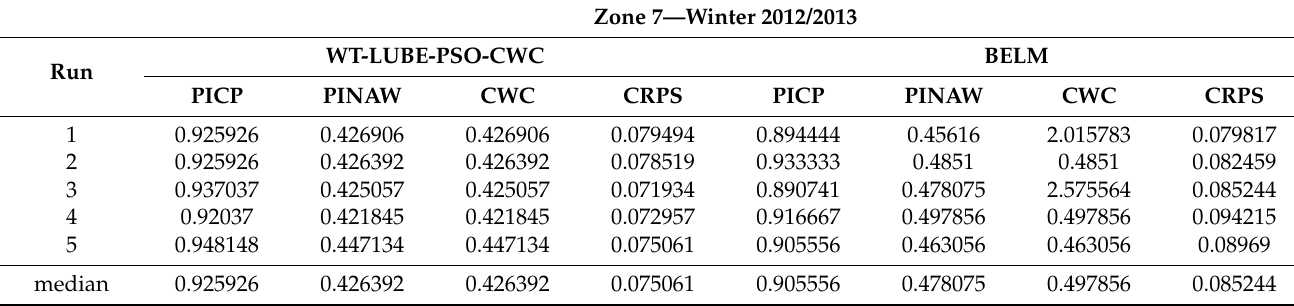
Table 9. Results of the evaluation of 5 training sessions of WT-LUBE-PSO-CWC and BELM models in zone 7 for winter 2012/2013 at the 0.9 confidence level.